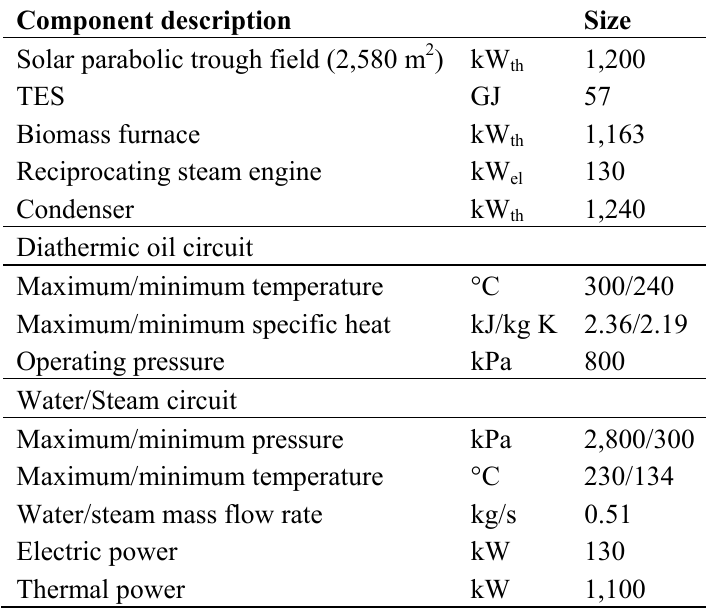
Table 1. Main components description and nominal